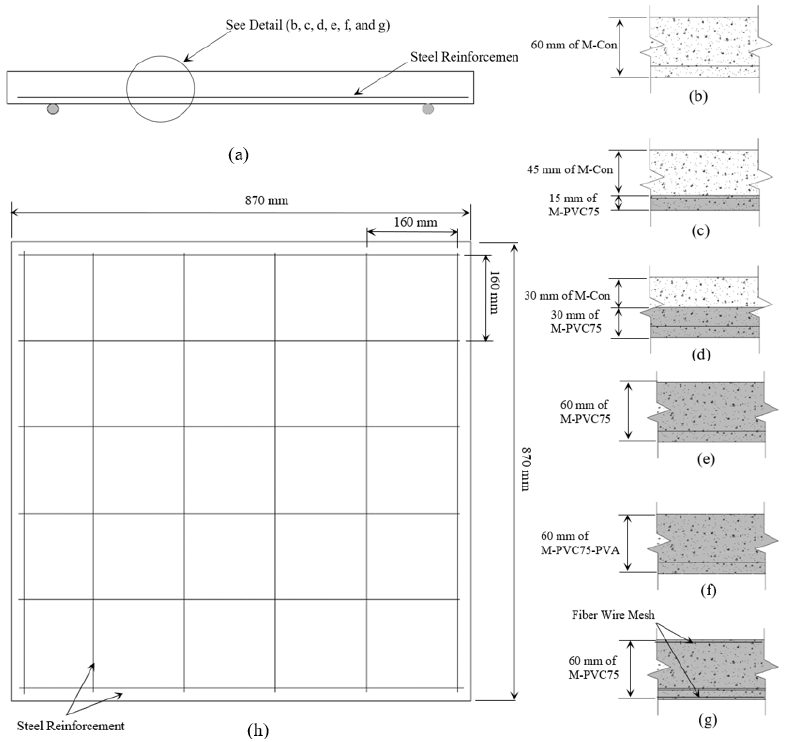
Figure 4. ( a ) Elevation view, ( b ) Con, ( c ) PVC-15, ( d ) PVC-30, ( e ) PVC-60, ( f ) PVC-60-PVA, ( g ) PVC-60-Fiber, ( h ) plan view specimens.